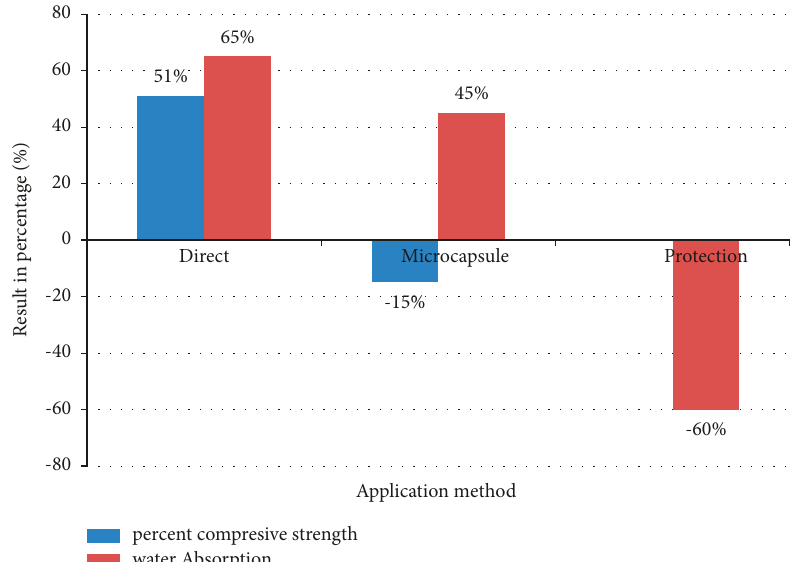
Figure 2: Compressive strength and water absorption ability of cement mortar made of Bacillus sphaericus with varying application methods [21].